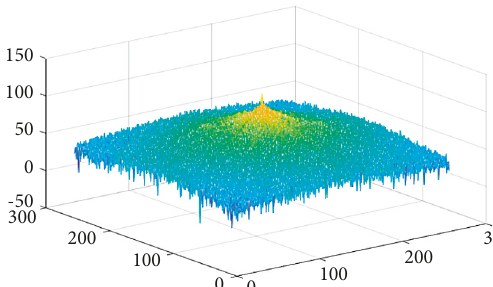
Figure 5: Noisy brain BMP scan